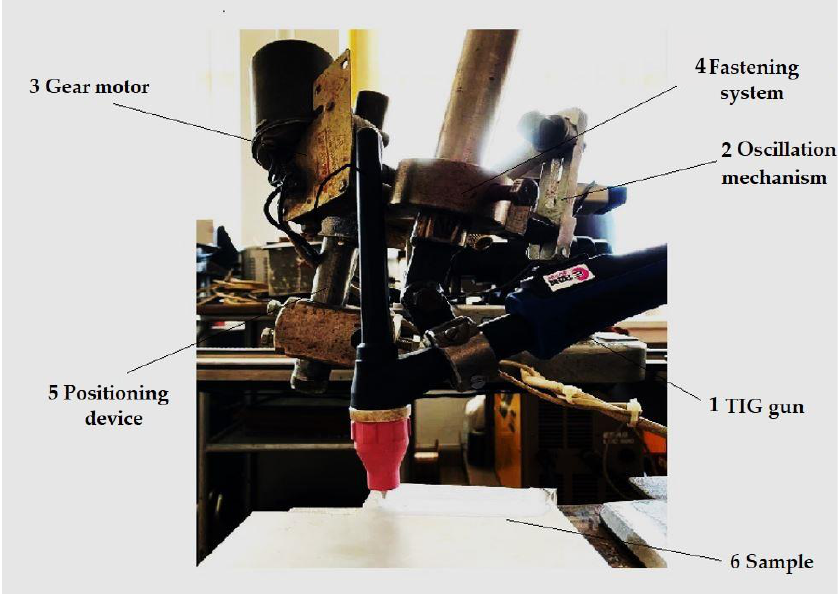
Figure 3. The welding experimental stand.